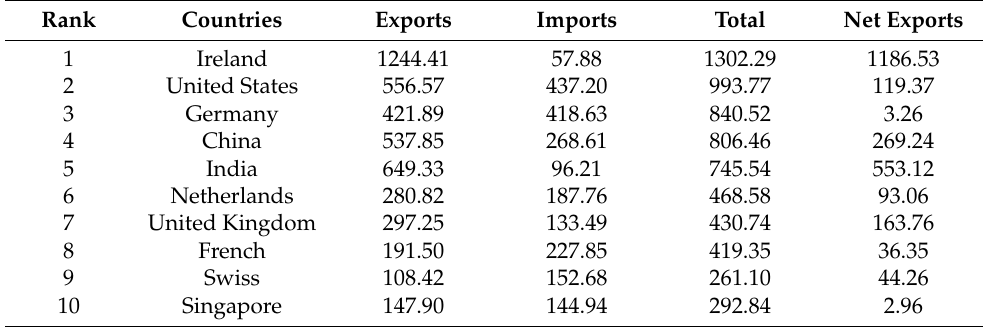
Table 2. World ranking of computer information service trade in 2019 (Unit: 100 million U.S. dollars).